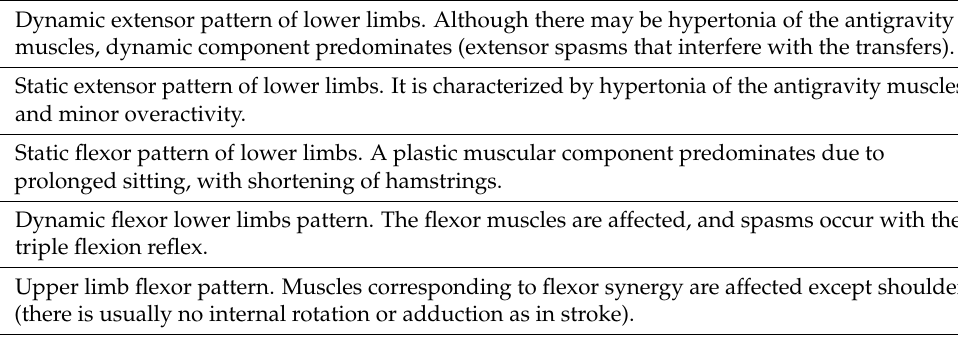
Table 1. Main patterns of spasticity in spinal cord